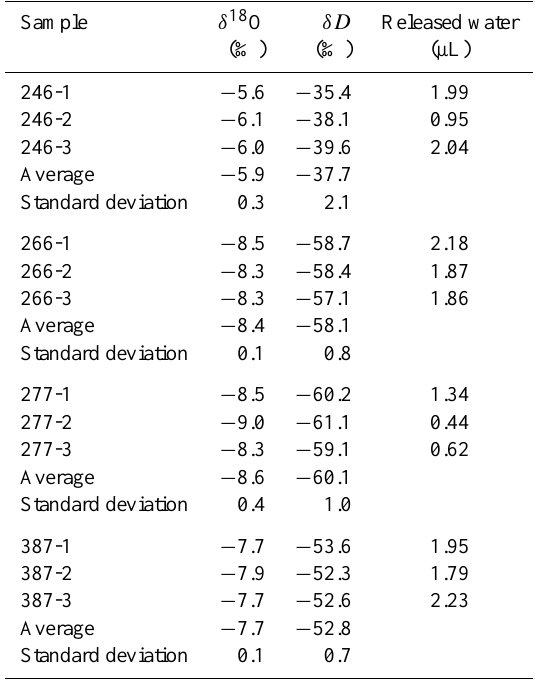
Table 4. Experimental results with crushed speleothem samples from Borneo.